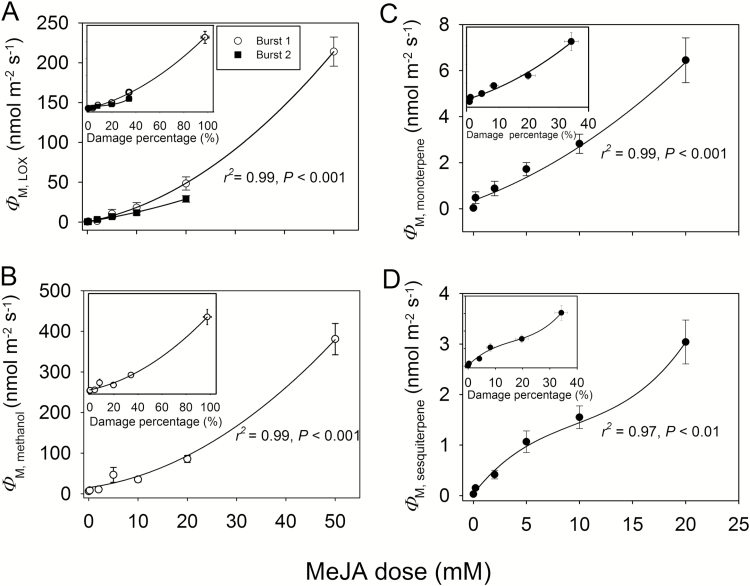
Maximum emission rates of LOX (Φ
M,LOX, A), methanol (Φ
M,methanol, B), monoterpenes (Φ
M,monoterpene, C), and sesquiterpenes (
Φ
M,sesquiterpene, D) as dependent on the applied MeJA dose and corresponding correlations with the degree of damage at the end of the experiment (insets) in leaves of C. sativus (see Fig. 2 for sample-induced emission kinetics). MeJA treatments as in Fig. 1. Treatment with 50 mM MeJA was lethal (Fig. 1) and, thus, the second LOX emission burst and monoterpene and sesquiterpene emission bursts were absent at this concentration. Data were fitted by second-order polynomial regressions, except that sigmoidal regressions were used for (D). For the first LOX burst in (A), y=0.062x2+1.19x+0.46 (main panel) and y=0.013x2+0.89x–0.3 (inset). For the second LOX burst in (A), y=0.0335x2+0.94x+0.46 (main panel) and y=0.013x2+0.37x+1.05 (inset). For methanol in (B), y=0.11x2+1.65x+12.0 (main) and y=0.026x2+1.28x+10.9 (inset), for monoterpenes in (C), y=0.0037x2+0.23x+0.30 (main) and y=0.0023x2+0.098x+0.36 (inset), and for sesquiterpenes in (D), y=3.26/[1+e(9.80−x)/4.02] (main) and y=3.72/[1+e (21.5−x)/8.72]. For the relationships in (A–C), r2=0.99, P<0.001, except for the second LOX burst versus damage percentage in (A) where r2=0.98, P<0.01. In (D), r2=0.97, P<0.01 for the main panel and r2=0.96, P<0.01 for the inset. Three replicate treatments at each MeJA application concentration were carried out.